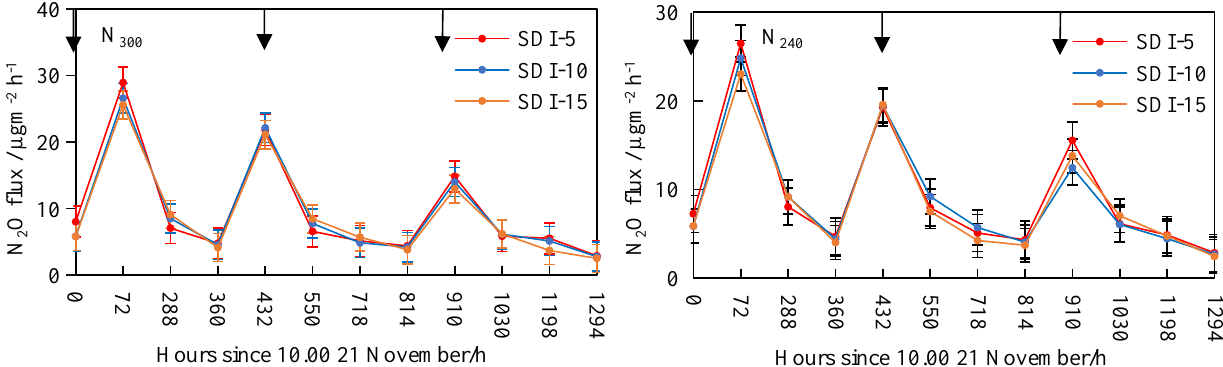
Figure 9. Trend of N 2 O flux under different SDI emitter depths over the whole experimental period. Each data point is the mean flux for five chambers replicated three times. Downward arrows represent a water and fertilizer application event. Error bars represent standard error.